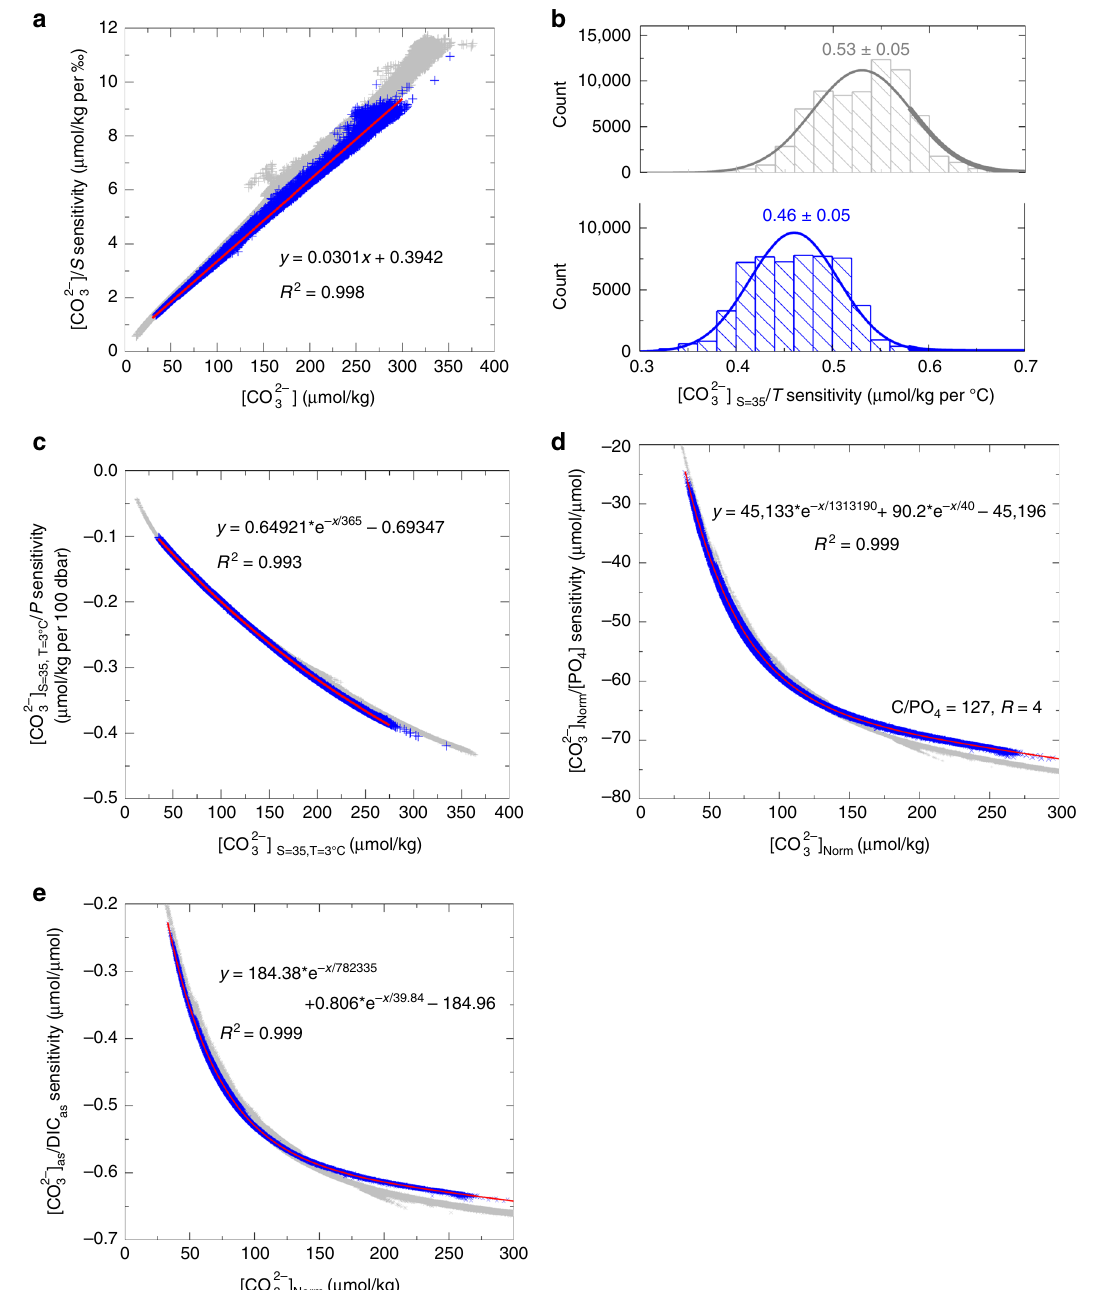
Fig. 4 Carbonate system sensitivities to various changes. a Salinity effect. b Temperature effect. c Pressure effect. d Biological effect. e Air – sea CO 2 exchange effect. Calculations are based on GLODAP 2 ( n = 55,399; blue) and a LGM output from LOVECLIM 58 ( n = 71,768; gray). For a – d , calculations assume no net air – sea CO 2 change. Best fi ts of data are shown by red curves. See Methods for calculation ) of 4 (refs. 3,10,29,30 ) to predict the ratio ( R , = C organic :C CaCO 3 biological trend. Raising LGM C/PO 4 to 140 (the high end value in today ’ s North Atlantic 30 ) and R to 8 (doubling of the modern value) could lower the LGM [CO 3 2 − ] as gradient by ~16 μ mol/kg (Supplementary Fig. 15), still leaving ~42 μ mol/kg [CO 3 2 − ] as